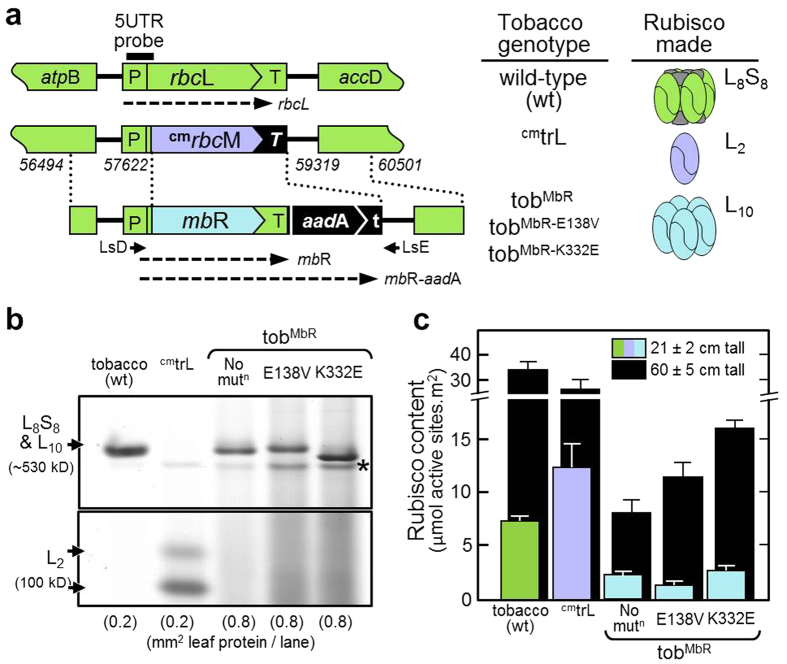
Transformation and expression of the mutated MbR enzymes in tobacco leaves.The varying cmmbR genes coding wild type and mutant MbR were integrated into the rbcL region of the tobacco plastome by chloroplast transformation. (a) Comparison of the plastome sequence and types of Rubisco made in the varying tobacco genotypes examined. The cmmbR and selectable marker aadA gene in the pLEVMbR, pLEVMbR-E138V and pLEVMbR-K332E transforming plasmids were transformed into the plastome of the cmtrL tobacco genotype to replace the cmrbcM (that codes R. rubrum L2 Rubisco31) by homologous recombination of the flanking plastome sequence (located between the dashed lines, numbering relevant to Genbank sequence Z00044). P, 292-bp rbcL promoter/5′UTR; T, 288-bprbcL 3′UTR; T, 112-bp of psbA 3′UTR; t, 147-bp rps16 3′UTR. Alignment position for primers LsD and LsE32 and the 221-bp 5UTR probe8 are shown. (b) native PAGE analysis of the L8S8, L2 and L10 Rubisco isoforms produced, respectively, in leaves from tobacco, cmtrL and the three tobMbR genotypes. *non-Rubisco protein. (c) 14C-CABP quantification of Rubisco active site content in comparable young upper canopy leaves of each genotype during early (~20 cm in height, colored bars) and late (~60 cm in height, black bars) exponential growth.